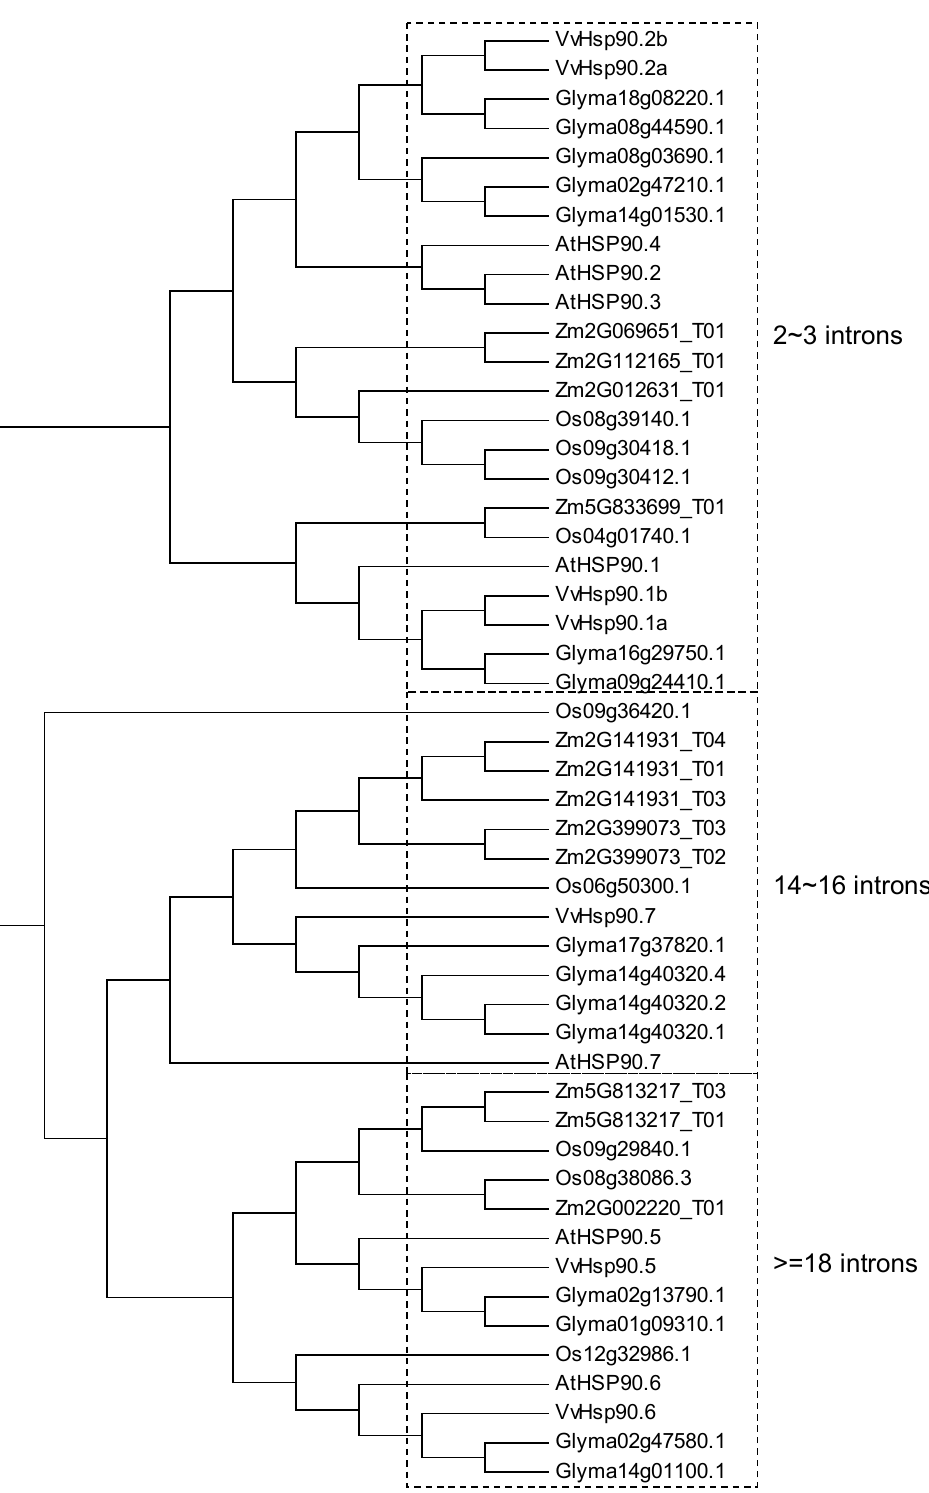
Figure 4. Phylogenetic tree of Hsp90 genes from model plants. Alignments of protein sequences were performed using the CLUSTALW program [68] with default parameters. The rectangular phylogram of the Hsp90 protein sequences was generated using MEGA 4.1 [69]. Abbreviations: AT, Arabidopsis thaliana ; Os, Oryza sativa ; Glyma, Glycine max ; Zm, Zea mays